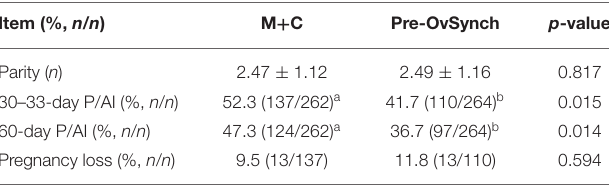
TABLE 1 | The parity, 30–33-day P/AI, 60-day P/AI after first AI, and pregnancy loss of postpartum cows treated with the M + C and Pre-OvSynch program. Item (%, n / n )